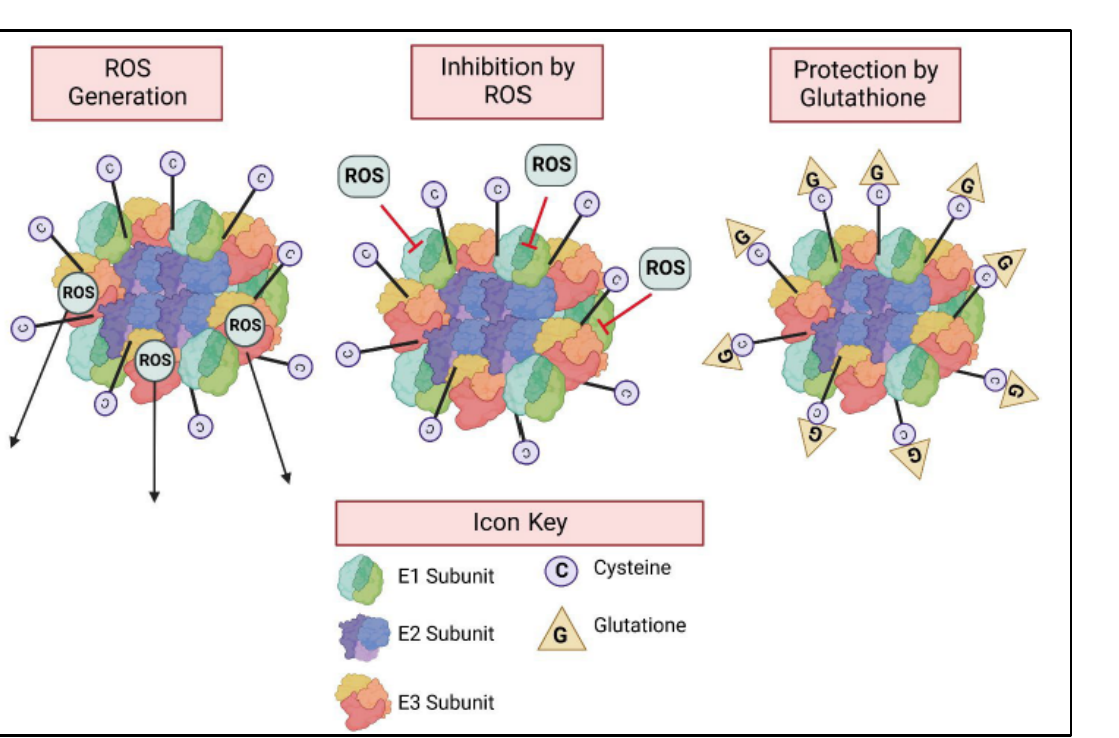
Figure 4. α -ketoglutarate dehydrogenase complex (KGDHC) and cell signaling by reactive oxygen species (ROS). The E3 subunit of KGDHC produces ROS. When KGDHC is active, ROS inhibits the E1 subunit and inhibits the overall activity of the complex. Glutathionylation protects KGDHC against ROS. Glutathione binding to the cysteine residues of KGDHC inactivates KGDHC and prevents ROS from damaging the complex.